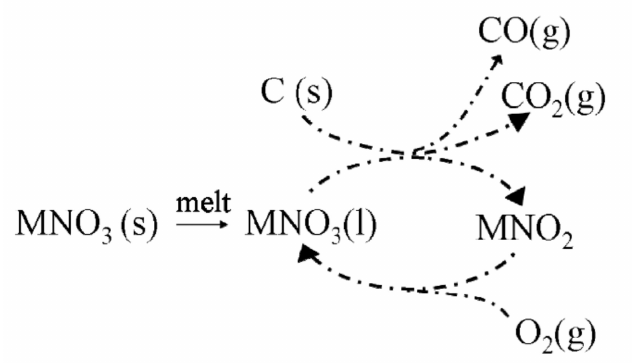
Figure 8. The mechanism of soot oxidation on molten salt [119]. Copyright 2008, WIT